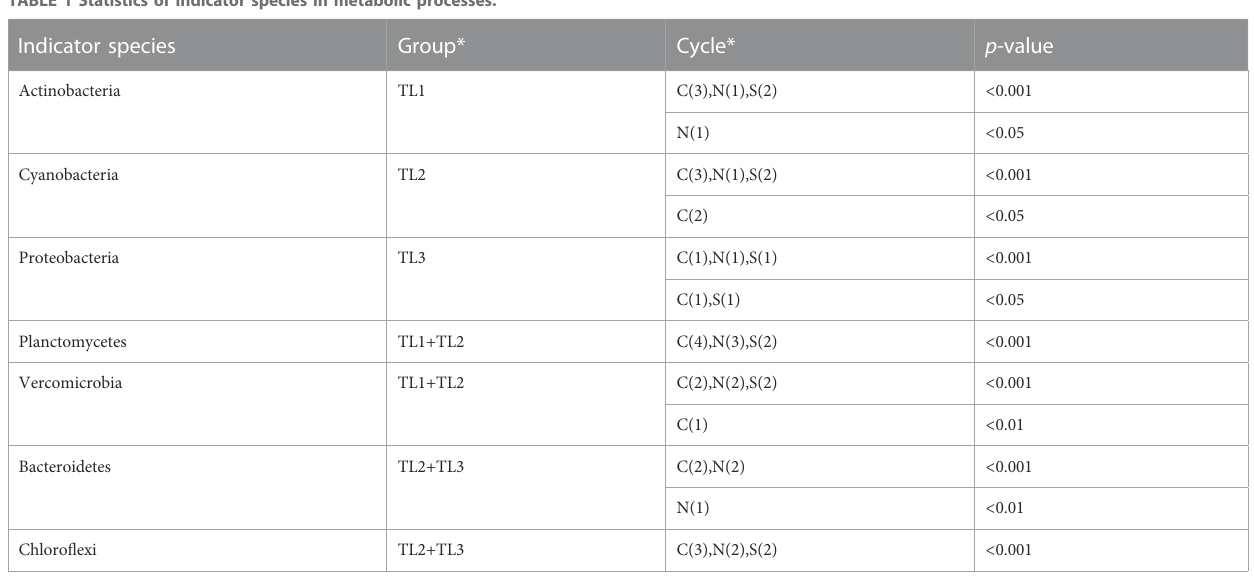
TABLE 1 Statistics of indicator species in metabolic